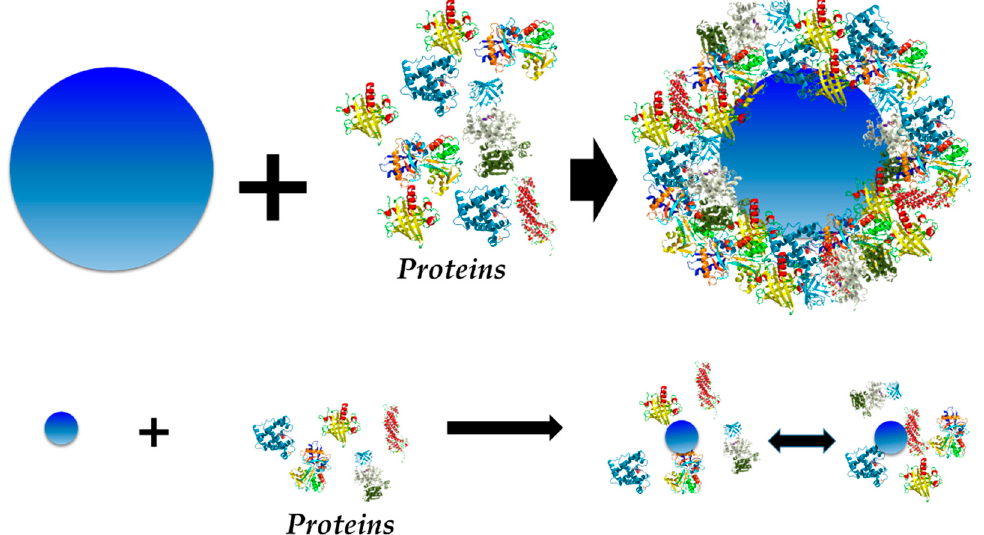
Figure 7. Schematic representation of the results obtained by Liu et al. [84] for 6–9 nm cerium oxide NPs—no HC formation, just SC—vs. the HC usually observed for larger NPs (cross-section).